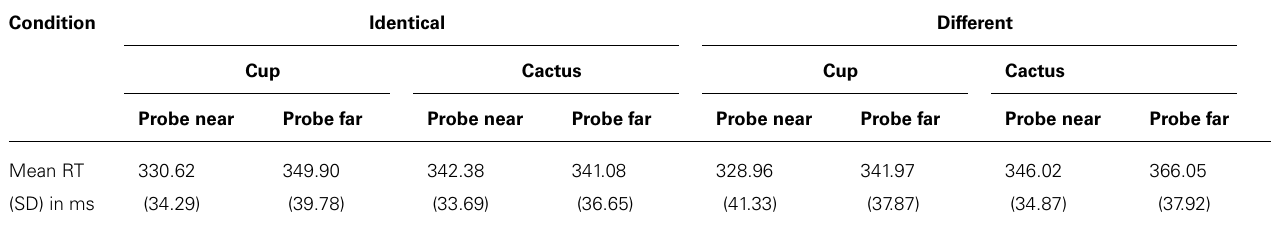
Table 1 | Mean reaction times in all eight conditions, Experiment 1.